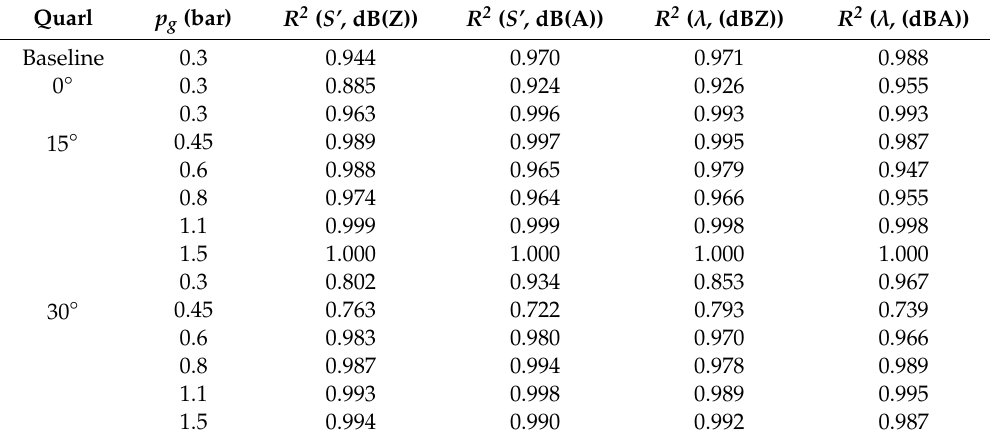
Table 3. The coefficient of determination of linear fit lines for A- and Z-weighting functions as a function of S’ and λ .